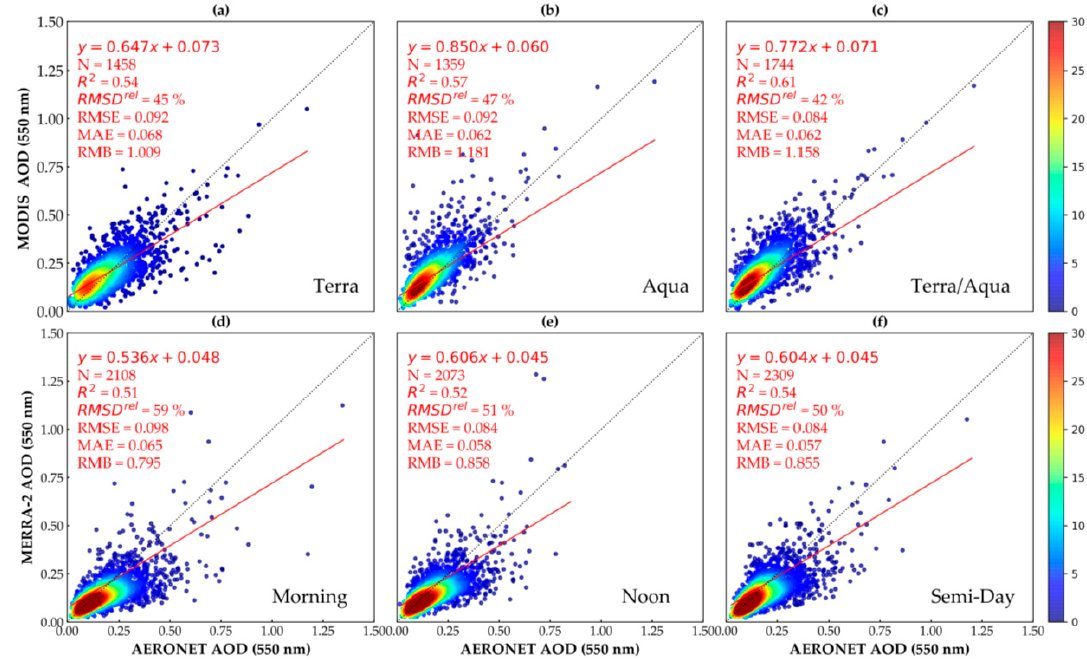
Figure 1. Validation of Moderate Resolution Imaging Spectroradiometer (MODIS) Aqua and Terra, and Modern-ERA Retrospective Analysis for Research and Application (MERRA-2) AOD against Aerosol Robotic Network (AERONET). ( a ) MODIS TERRA vs. AERONET, ( b ) MODIS Aqua vs. AERONET, ( c ) MODIS Aqua and Terra combined vs. AERONET, ( d ) MERRA-2 morning vs. AERONET, ( e ) MERRA-2 noon vs. AERONET, ( f ) MERRA-2 combined (semi-day) vs. AERONET. The color bars indicate the frequency of match points values.